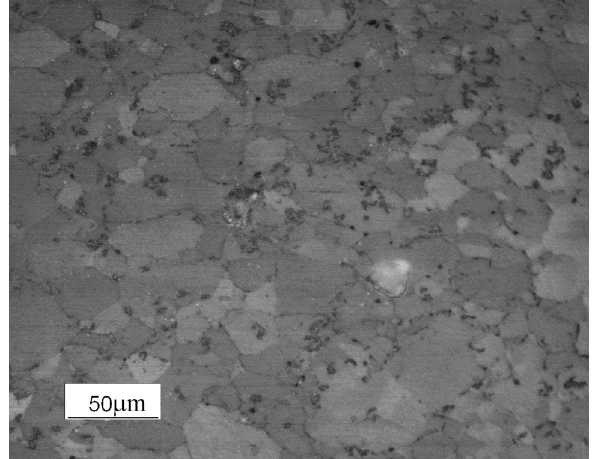
Figure 3. Optical micrographs showing microstructure of a